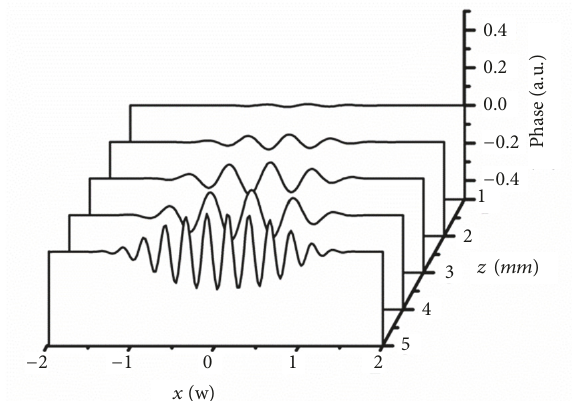
Figure 2: Evolution of signal phase in the transverse direction of nonlinear crystal under saturation amplification conditions ( E 0 = 10 −2 ; L = 0.23 L , L = 5 L , a = 0.5, n = 4, L = 5 NL sp